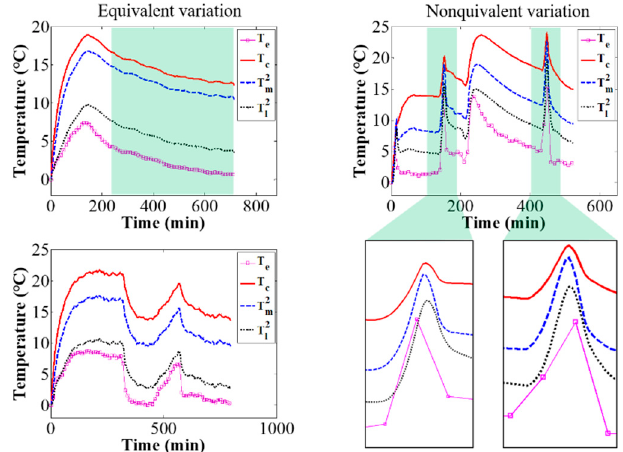
Figure 13. Experimental results of camera component temperatures with increasing environmental temperature variation rate.